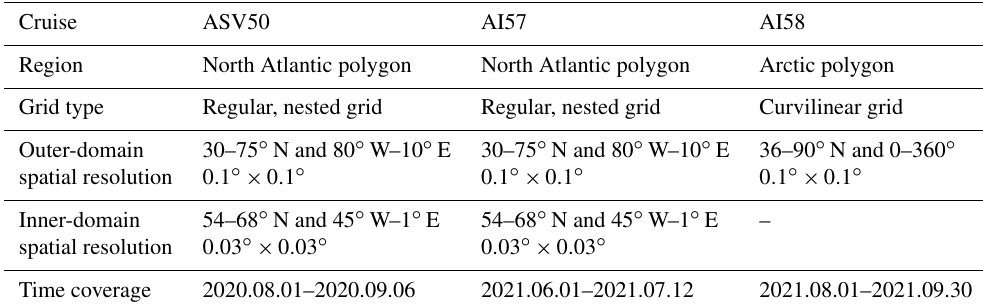
Figure 4. Spotter wave buoy time series of vertical displacements at station no. 3946 in the AI58 cruise (a) , corresponding wave energy spectrum (b) , and location of station no. 3946 (c) . Table 3. WW3 model configuration over the domains of